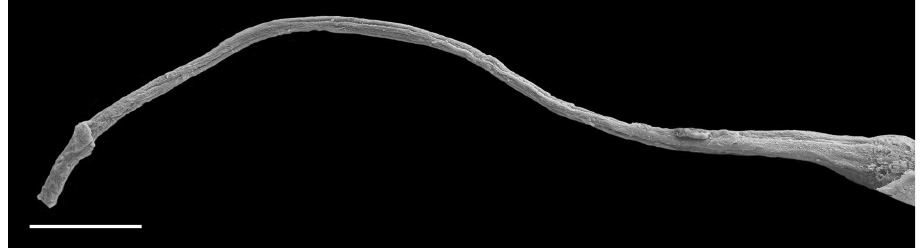
Figure 65. Penis, Wallaconchis melanesiensis , Papua New Guinea, Madang, scale bar 10 μm [5421]